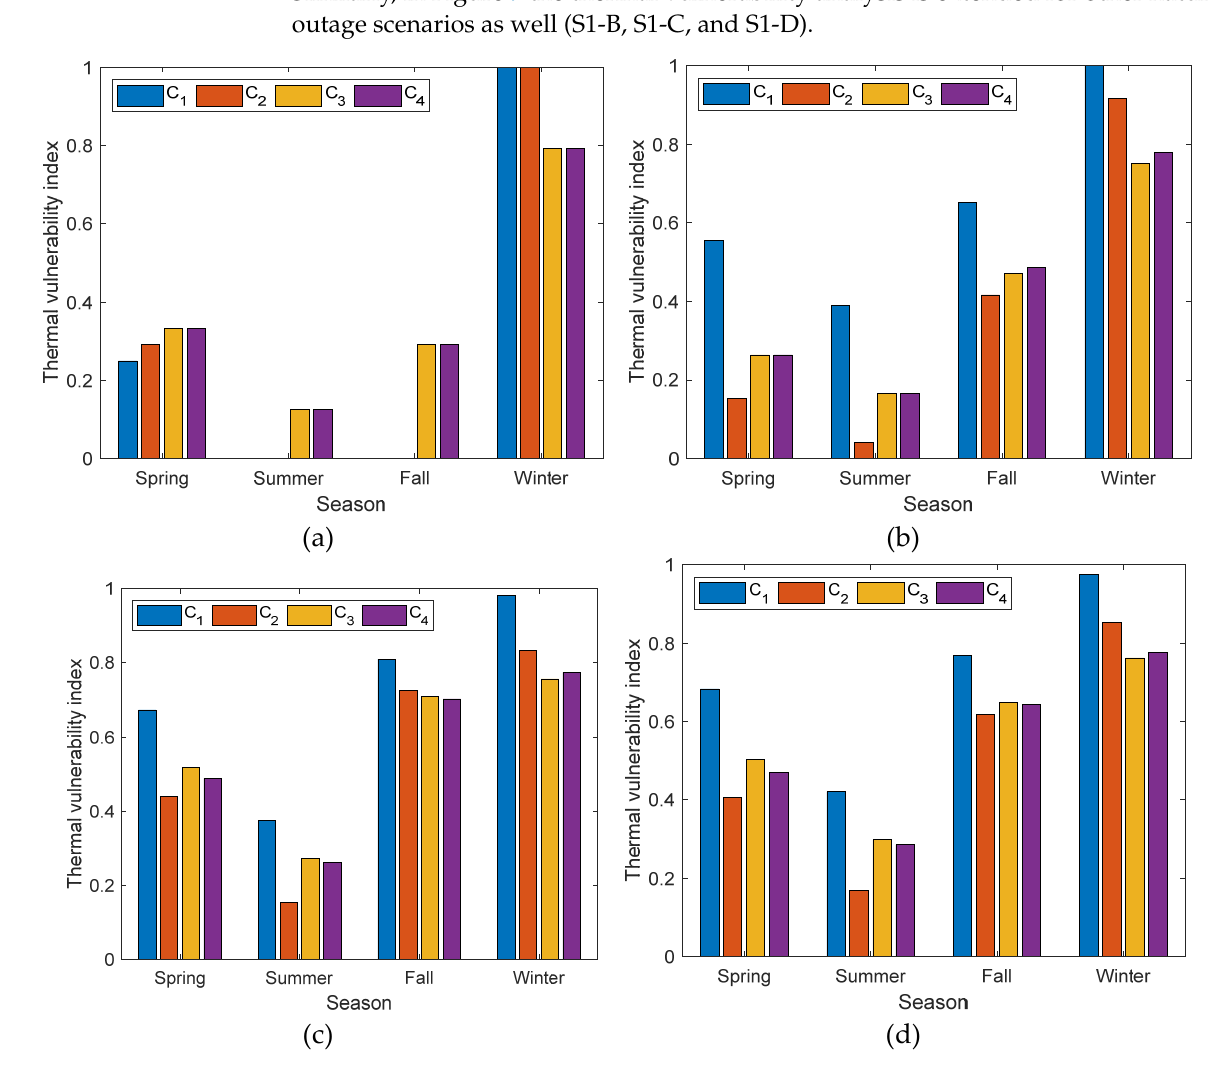
Figure 9. Thermal vulnerability analysis for various NU combinations for ( a ) S1 − A, ( b ) S1 − B, ( c ) S1 − C, and ( d ) S1 − D scenarios.